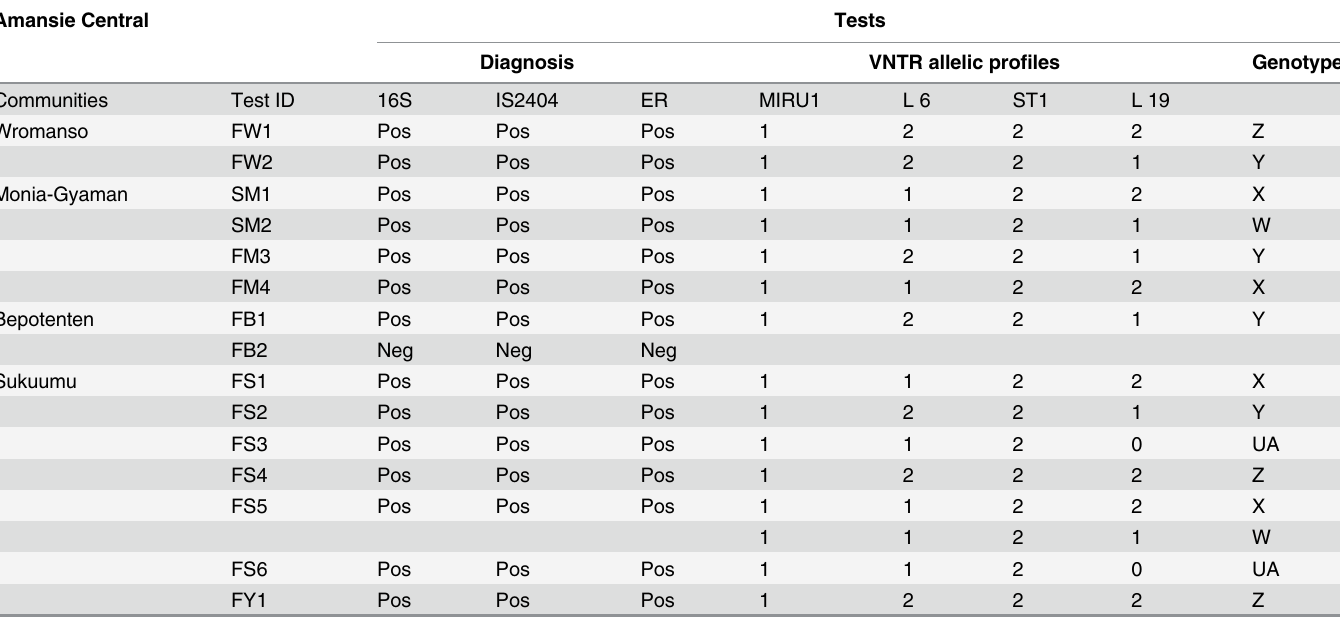
UA, unassigned. PCR ampli fi cation of Locus 19 was unsuccessful for FS3 and FS6. Locus 6 and Locus 19 were the main determinants for a genotype. Patient, FB2 was negative for MU. Pos, positive, Neg = negative, L6 = locus 6, L19 = locus